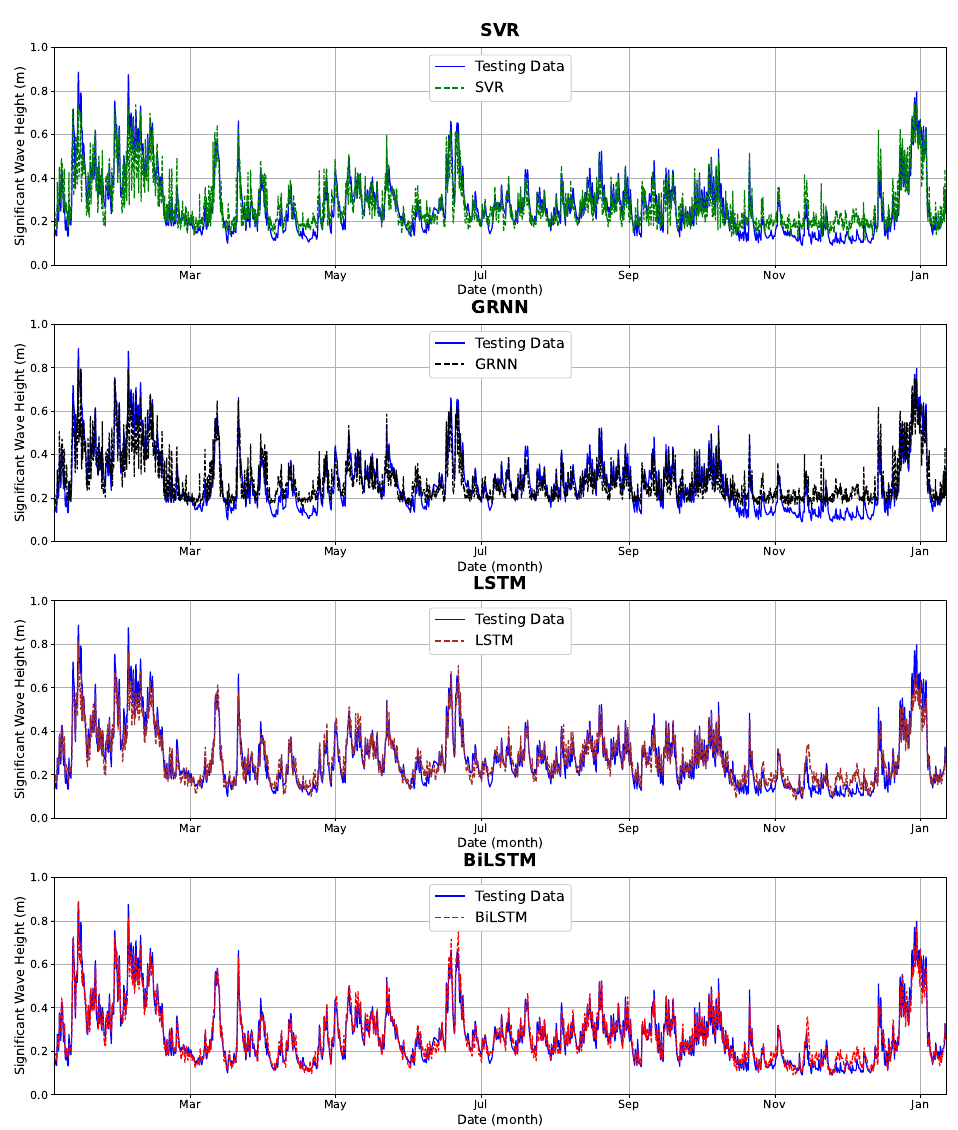
Figure 14. Results of significant wave height forecasting at the observation point in Jakarta Bay using the SVR, GRNN, LSTM, and BiLSTM